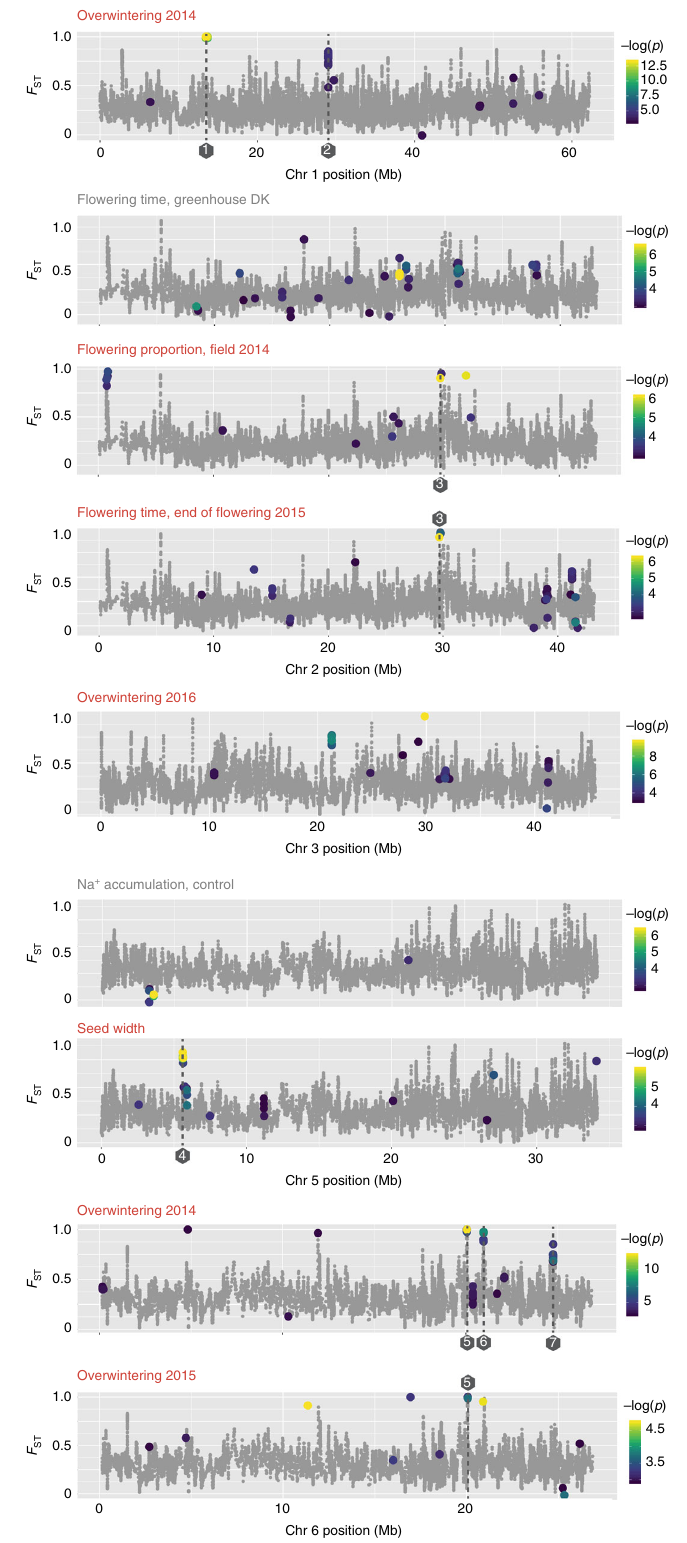
Methods Read mapping and variant calling . The wild Lotus accessions used in this study can be obtained from Legume Base (https://www.legumebase.brc.miyazaki-u.ac.jp). All samples were sequenced using Illumina paired-end reads (ENA accession PRJEB27969). The reads were mapped to the L. japonicus genome version 3.0 (http://www.kazusa.or.jp/lotus/) using Burrows-Wheeler Aligner (BWA) mem v0.75a with default parameters 26 . An average of 96% of the reads were mapped and recalibration of the scores was done using the BaseRecalibrator , and the BAM fi